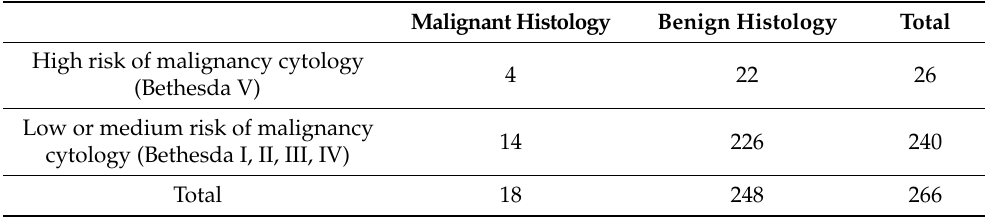
Table 5. Cytology assessment by categories of risk for malignancy (low and medium risk, and high risk of